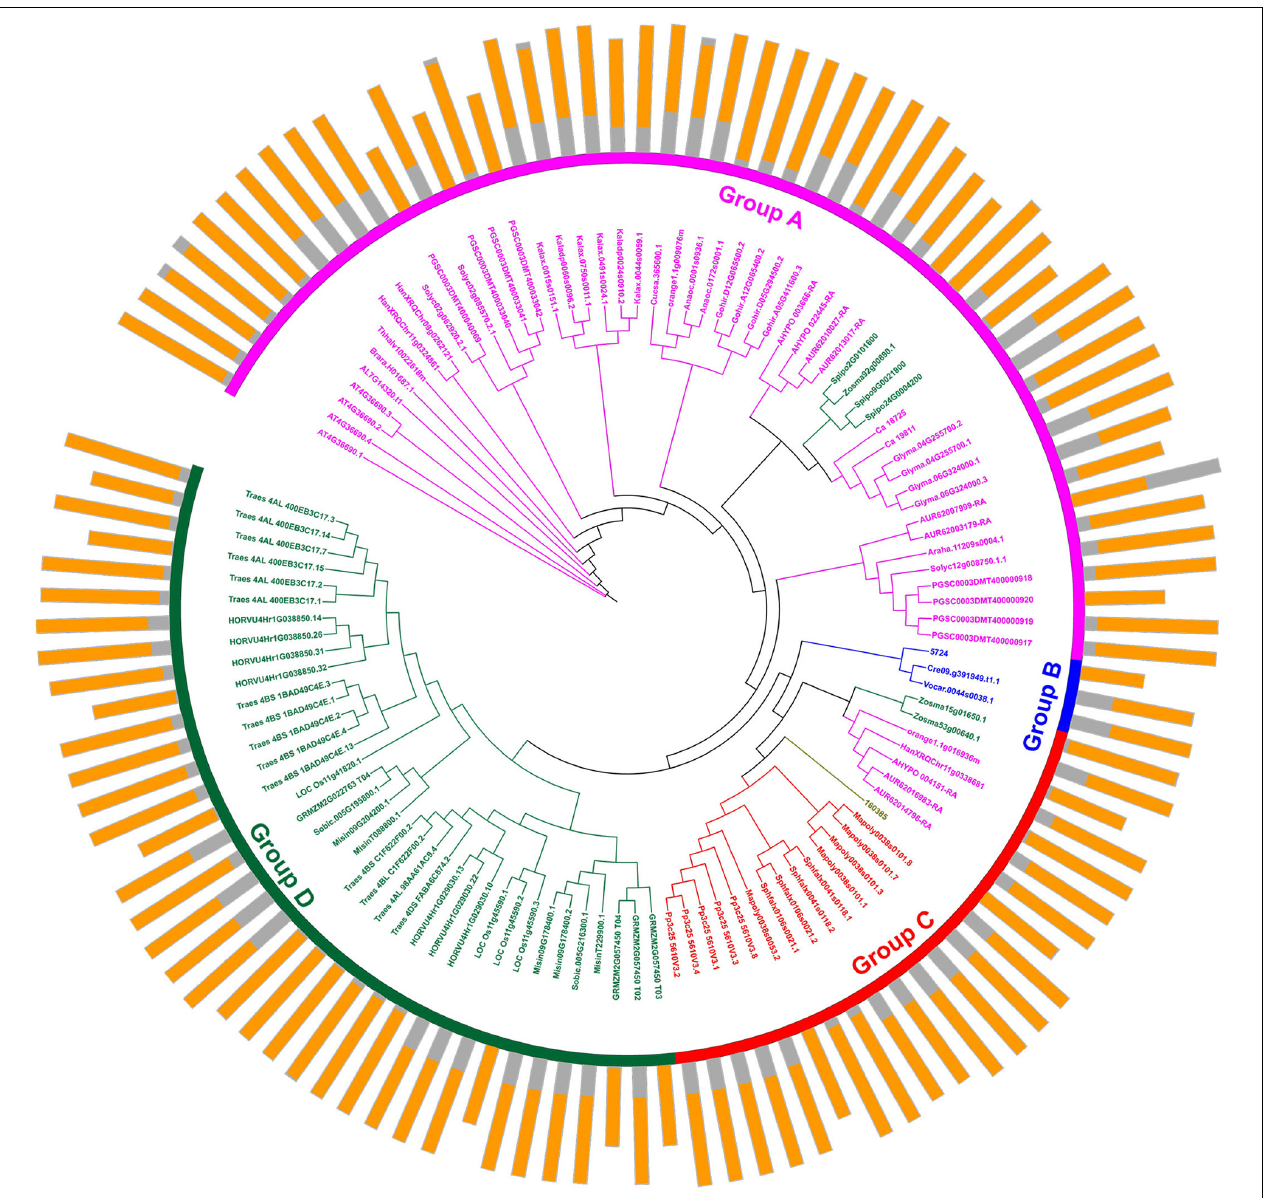
FIGURE 2 | Protein structure organization amongst plant U2AF65A genes. The protein structure (outer ring) is displayed on the outermost side, and the amino acid sequence extends from the inside to the outside, the yellow parts of the bar represent the RNA-recognition motif (RRM), and the gray parts of the bar represent the full-length amino acid sequence of the protein. A circular phylogenetic tree (inner ring) is displayed